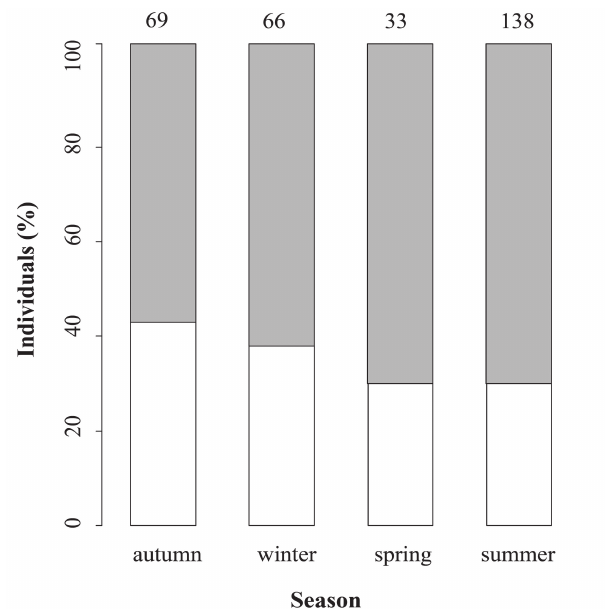
Fig. 2. Frequency of Epinephelus itajara sighted per austral season in natural (white bar) and artificial (grey bar) habitat between 2005 and 2011. Numbers above each bar represent total number of individuals per season.